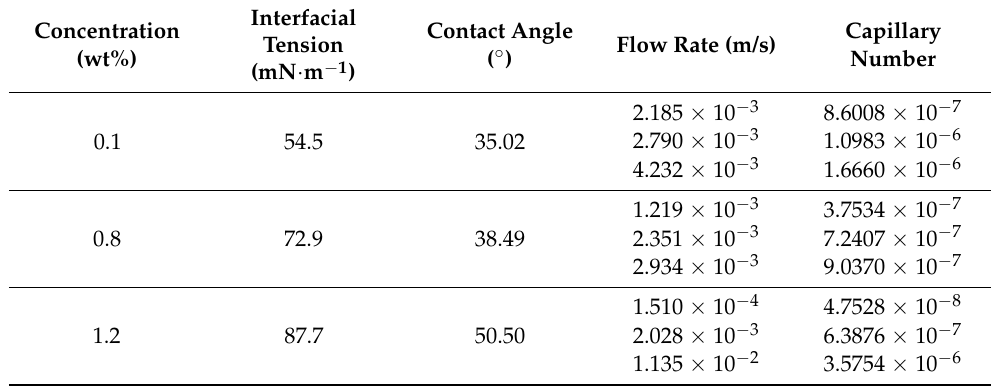
Table A1. List of the main